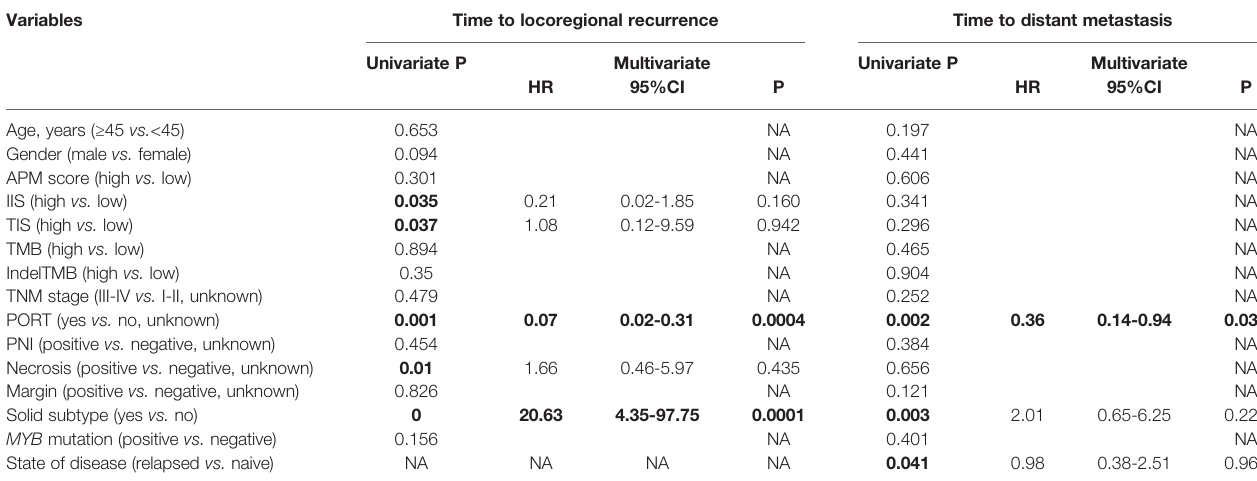
TABLE 2 | Univariate and multivariate analyses of factors associated with time to locoregional recurrence and distant metastasis in ACC cohort (N=61).